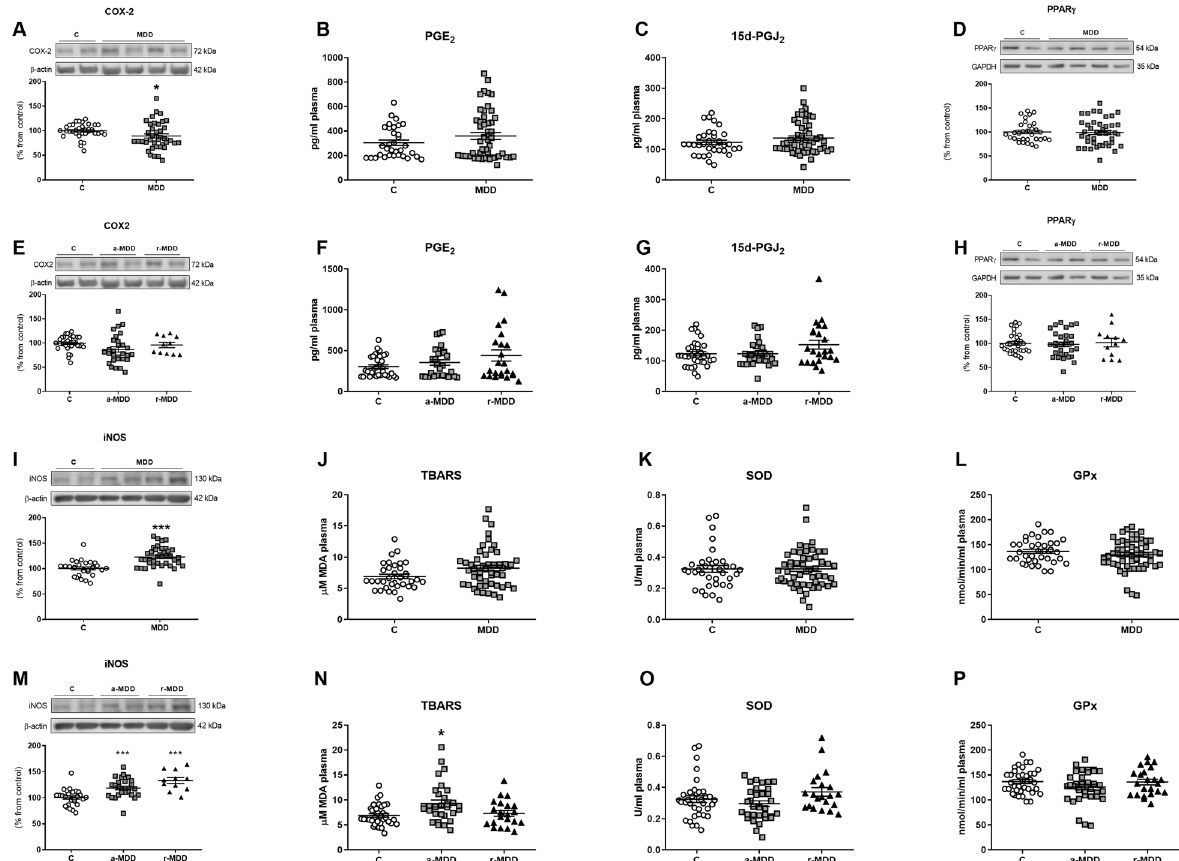
Fig. 4 Effects of the MDD on the cyclooxygenase-2 pathway, on the oxidative/nitrosative response, and on counterbalancing mechanisms. Patients with MDD presented lower levels of COX-2 expression in PBMCs ( A ) compared with HC, without changes in PGE 2 ( B ) and in 15d-PGJ 2 ( C ) plasma levels. The MDD did not affect the PPAR γ expression ( D ). The a-MDD and r-MDD groups did not show any difference between them nor with the HC group ( E – H ). The MDD increased iNOS protein levels in PBMCs ( I ) but no affected the activity of TBARS, SOD and GPx ( J – L ). a-MDD and r-MDD groups presented increased iNOS expression in PBMCs ( M ). The a-MDD group shown increased TBARS levels compared with HC ( N ). There were no differences in the activity of SOD and GPx among groups ( O , P ). Data are expressed as mean ± standard error of the mean (SEM). In the western blots the densitometric data of the respective bands of interest are normalized by β -actin or by GAPDH (lower band). Samples were from parallel experiments and that gels/blots were processed in parallel. An unpaired two- tailed t -test was performed when comparing two groups. For more than two groups comparisons, a one-way ANOVA with a Tukey post-hoc test was employed, and in those cases in which the data did not follow a Gaussian distribution, a nonparametric ANOVA with a Kruskal – Wallis test followed by a Dunn ’ s post-hoc test was performed. * p < 0.05, *** p < 0.001 vs. healthy controls